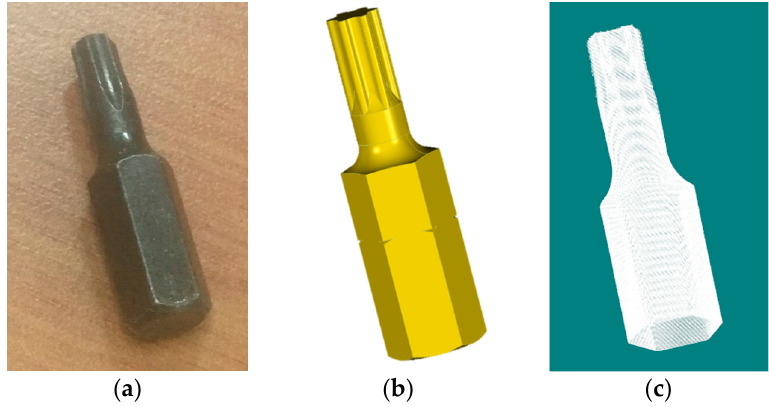
Figure 14. A workpiece surface profile information. ( a ) Physical photo of workpiece; ( b ) CAD model of workpiece; ( c ) MVS point cloud data of workpiece.